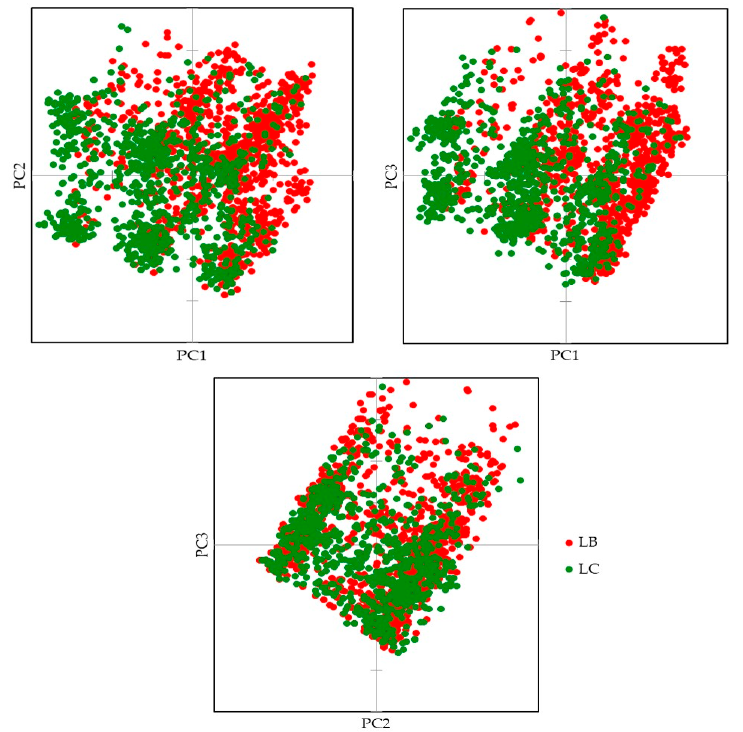
Figure 3. Principal Coordinate Analysis (PCA) of 2 genetic lines (Lowland-Caucasian LC and Lowland LB), based on 10 microsatellite markers (PC1 = 18.92%; PC2 = 14.48%; PC3 = 11.67%).